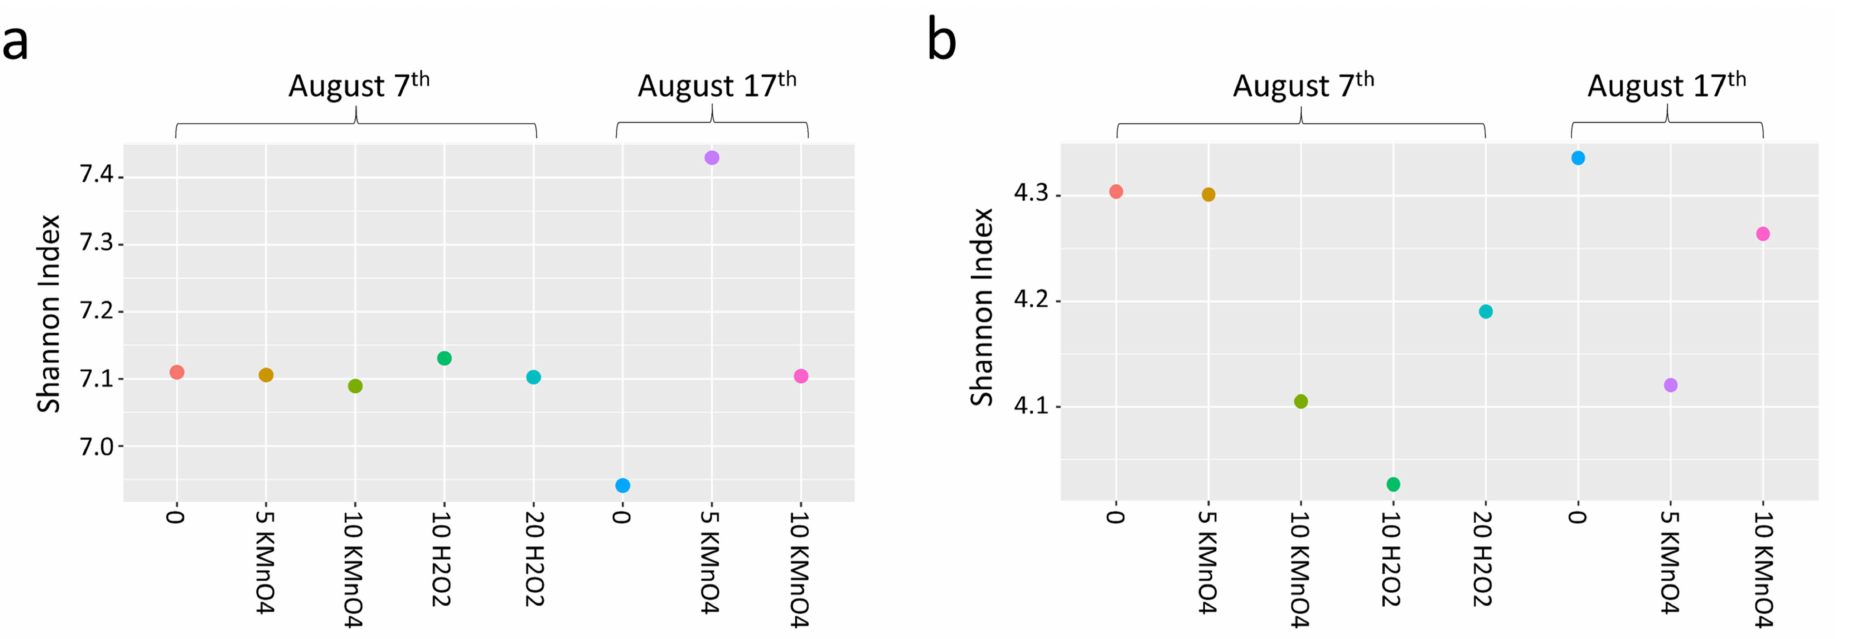
Figure 5. Impact of laboratory oxidation on ( a ) Microbial and ( b ) Cyanobacterial diversity (Shannon index) on 7 August and 17 August, 0: Sludge samples before